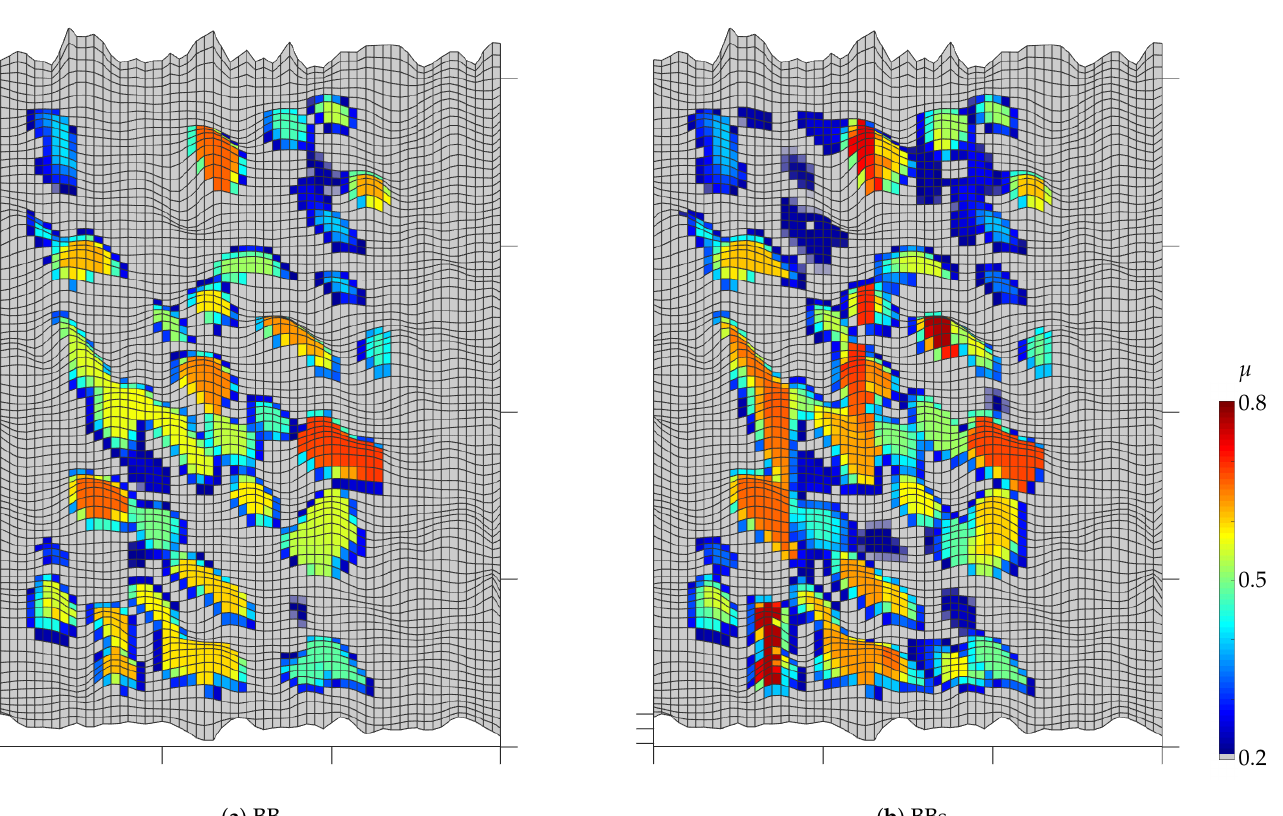
Figure 23. Local coefficient of friction on the road surface after 3ms at 140kmh − 1 for the patterns BBs and BBs. The error bars on the measured curves in Figure 20 indicate the standard